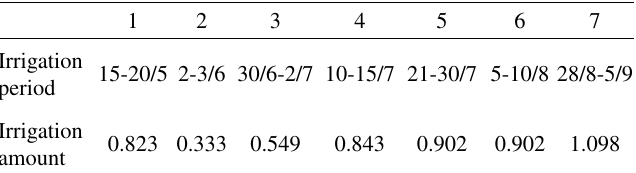
Table 3 - Irrigation supply periods and amounts (m 3 /tree)